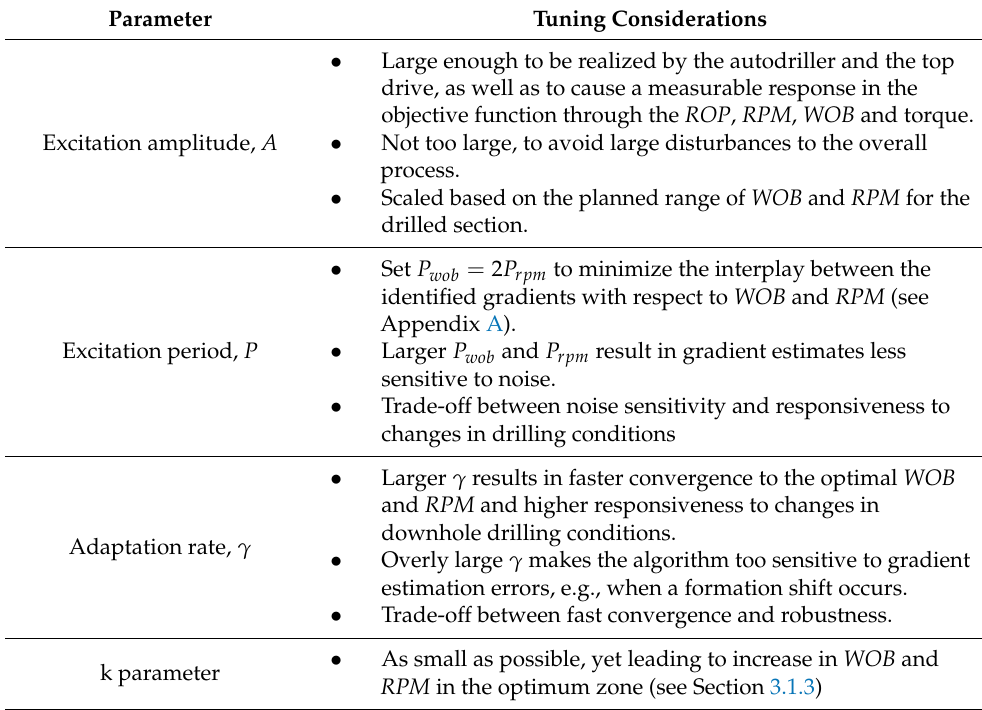
Table 1. Tuning considerations for key parameters in the ES